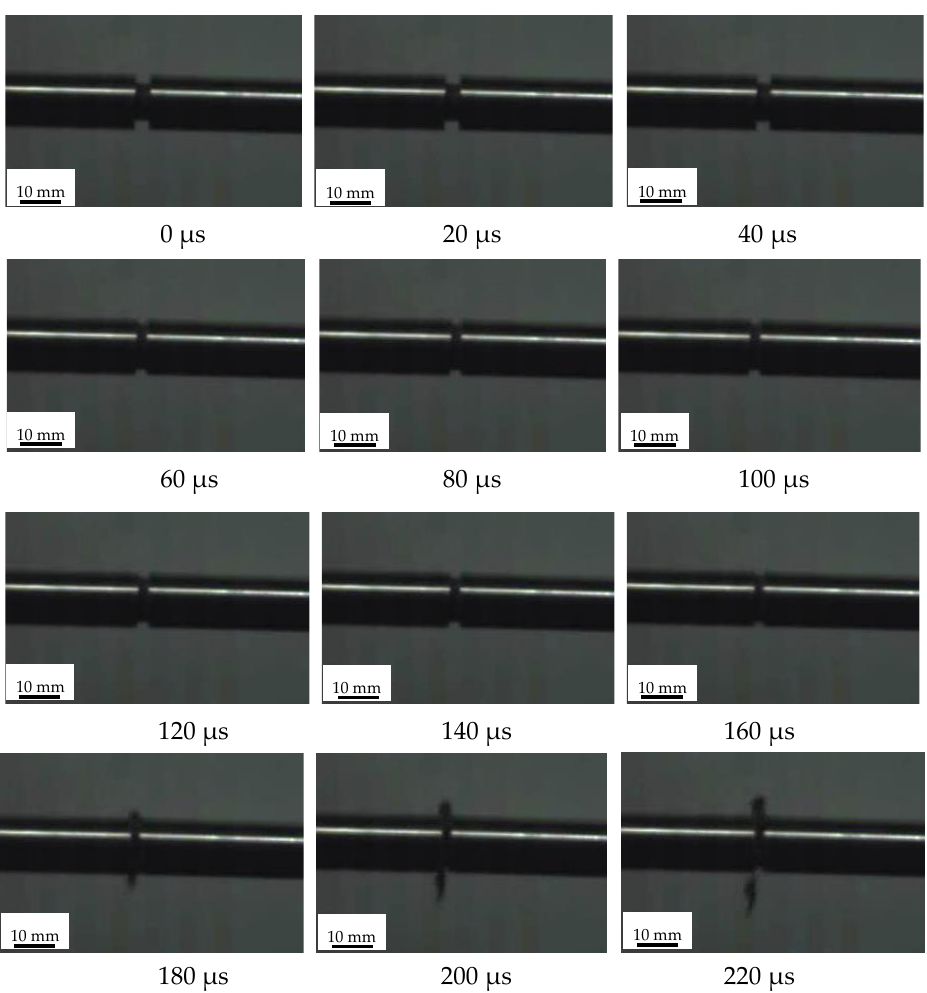
Figure 2. Schematic diagram of split-Hopkinson bar experimental device.